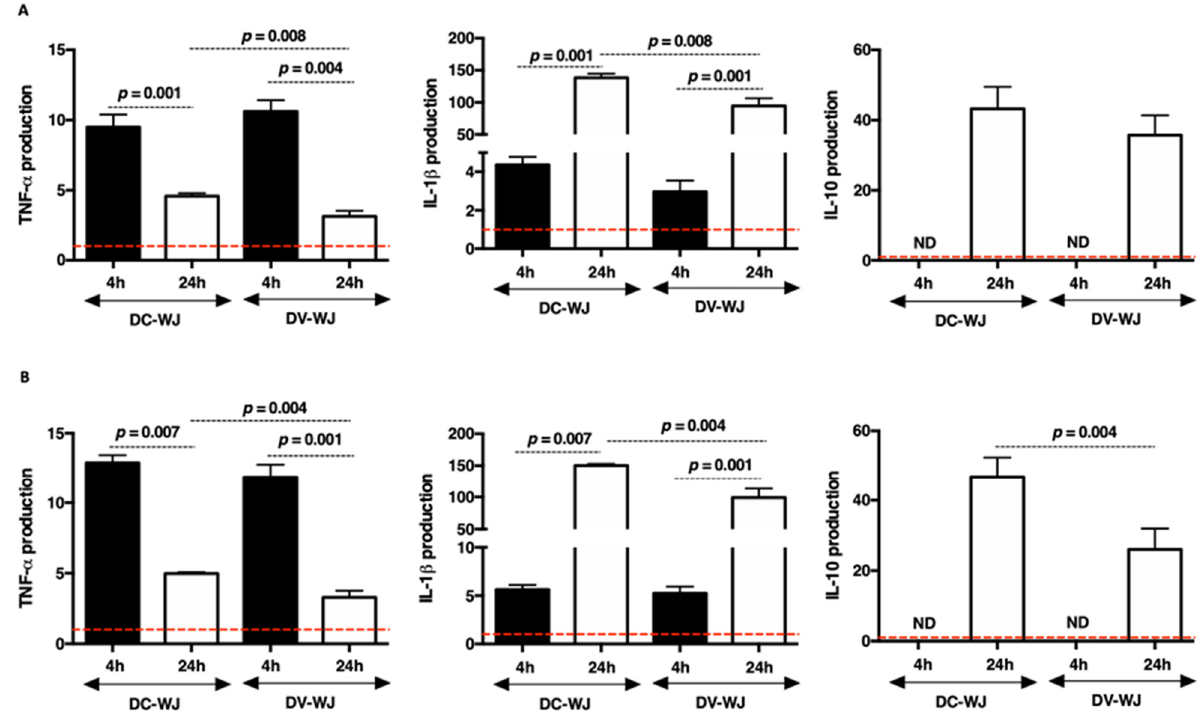
Figure 5. Innate monocyte responses to decellularized and devitalized Wharton’s Jelly. ( A ): cytokine production following contact with DC-WJ and DV-WJ. ( B ): cytokine production following contact with DC-WJ and DV-WJ co-stimulated with LPS. Results were normalized to the basal monocyte production indicated by the red dashed lines; n = 6, Wilcoxon–Mann–Whitney test.